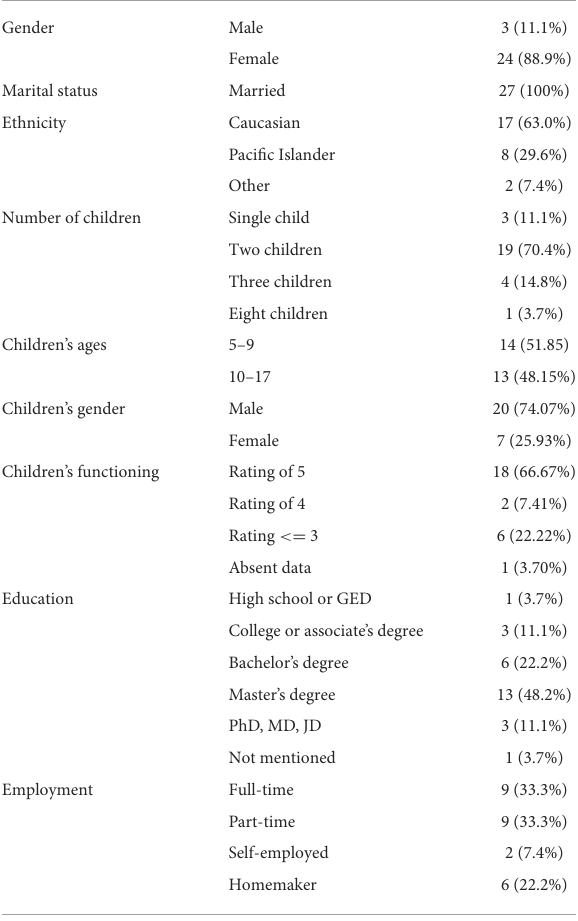
TABLE 1 Frequency distribution on participants’ demographic